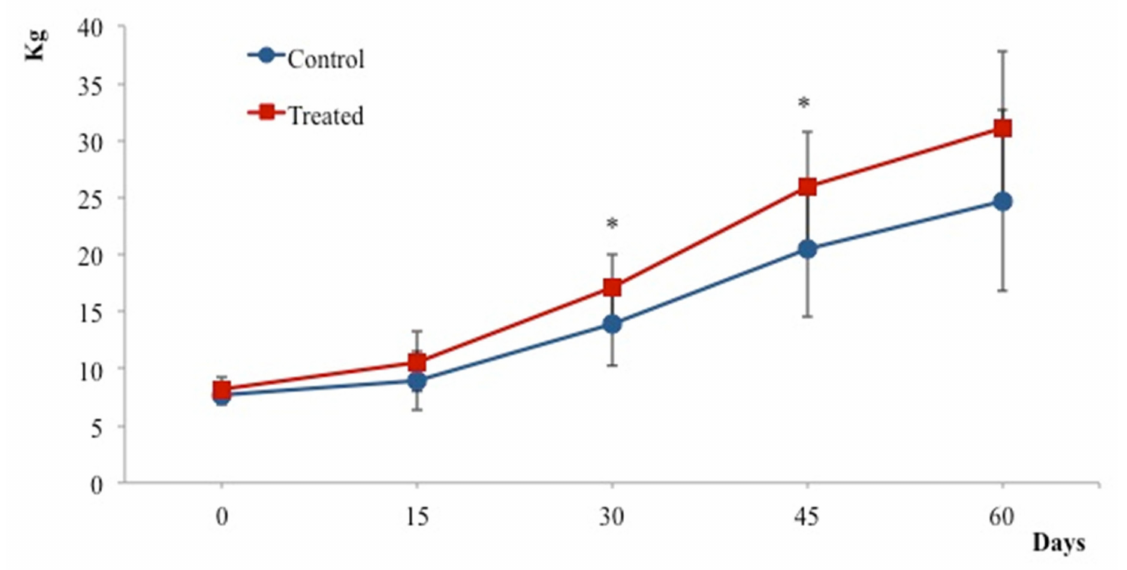
Figure 1. Effects of probiotic on body weight. The BT treated group shows a gradual increase in body weight following the experiment. Increase in body weight is significant 30 and 45 days following treatment. Values represent the mean ± SD. * p < 0.05 compared to controls.